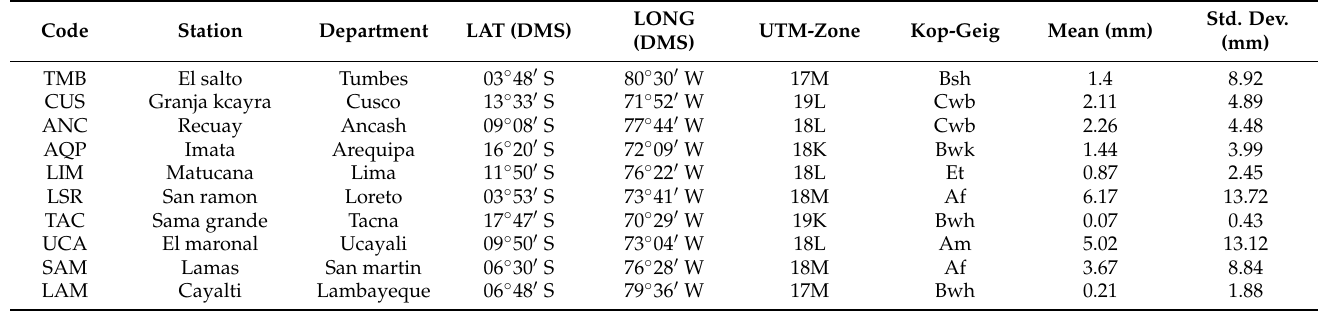
Table 1. Information of the meteorological stations and statistical characteristics of measured pre- cipitation (from 1990 to October).